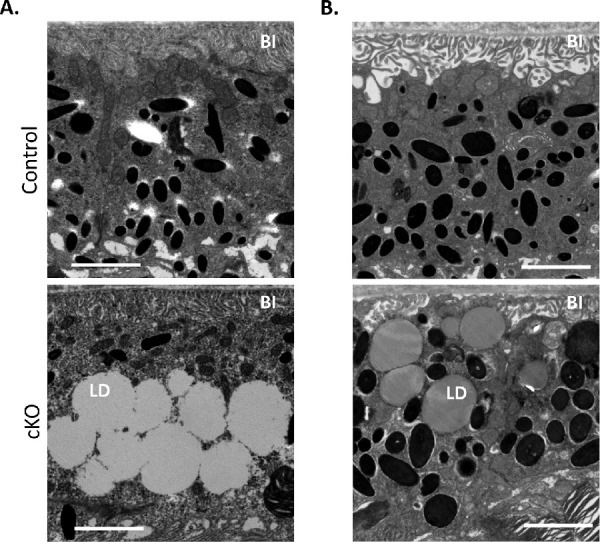
Lipid accumulation in the RPE of Pnpla2-cKO mice. Electron microscopy micrographs showing the RPE structure of 3-month-old (A) and 13-month-old (B) cKO mice and control animals. Scale bar: 2 µm. The representative images were selected among examinations of micrographs from eight eyes of cKO mice (PNPLA2f/f/Cre+), from seven eyes of PNPLA2f/f control mice at 1.75 to 3.75 months old, and from three eyes of cKO mice and three eyes of control mice at 12.5 to 13 months old. LD, lipid droplets; BI, basal infoldings.